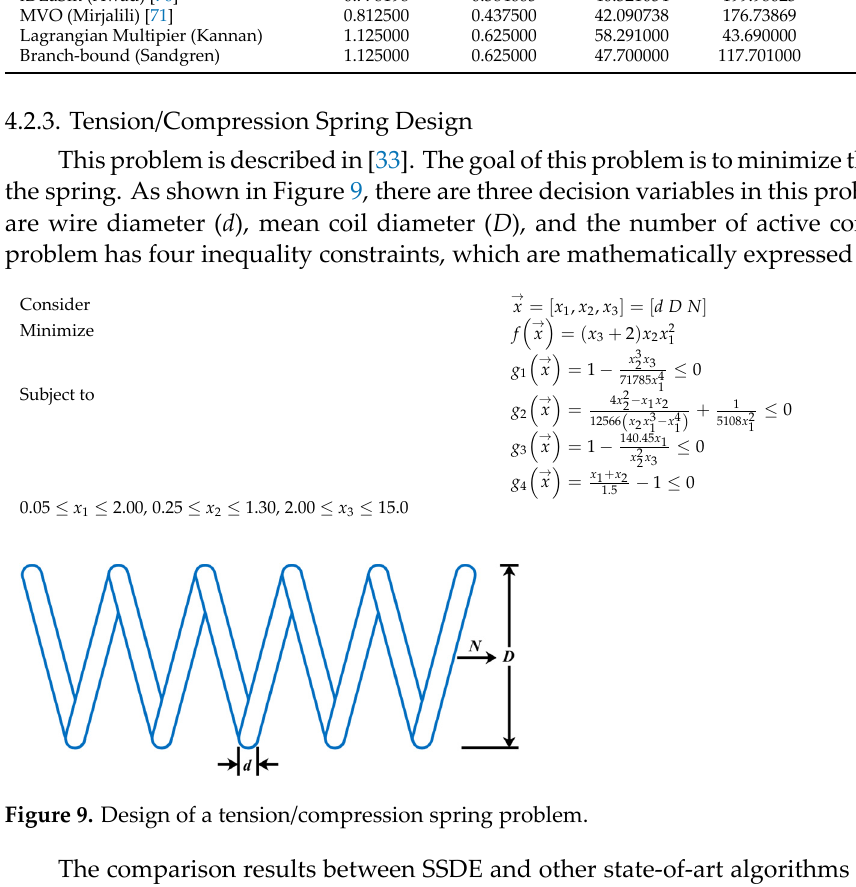
Table 8. Comparison of results of the tension/compression spring problem .